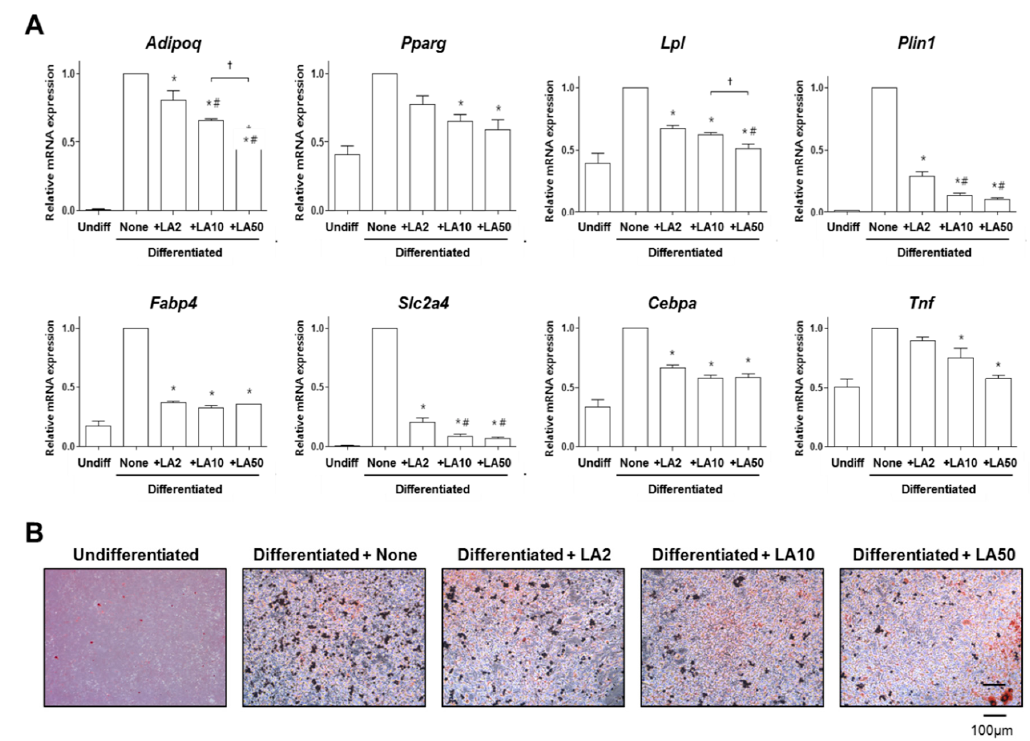
Figure 3. The effects of loganic acid on the mRNA expression of adipogenesis-related genes during adipocyte differentiation of 3T3-L1 cells. The cells were treated with 2, 10, or 50 μ g/mL of loganic acid (LA2, LA10, or LA50). ( A ) The expression levels of mRNA of 8 genes were calculated quantitatively by reverse-transcription real-time PCR using gene-specific primers and were then normalized to the Gapdh mRNA expression level. *: p < 0.05 vs. None, #: p < 0.05 vs. LA2, and †: p < 0.05 vs. LA10 (Tukey’s HSD post hoc test, ANOVA); ( B ) Lipid accumulation in 3T3-L1 cells was assessed by oil red O staining. Differentiated adipocytes were visualized under a microscope. Abbreviations: Undiff, Undifferentiated; None, non-treated.